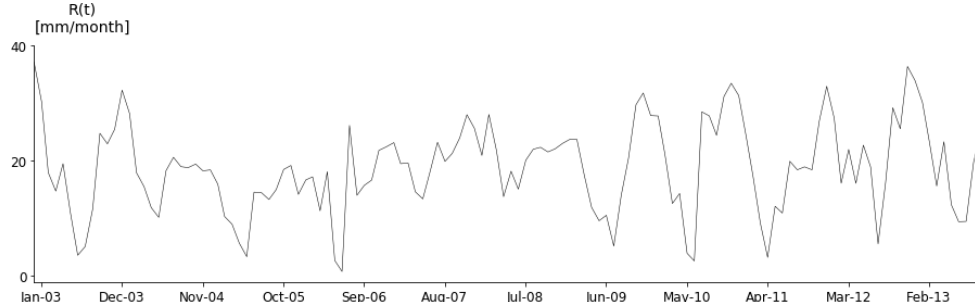
Figure 6. Average monthly groundwater